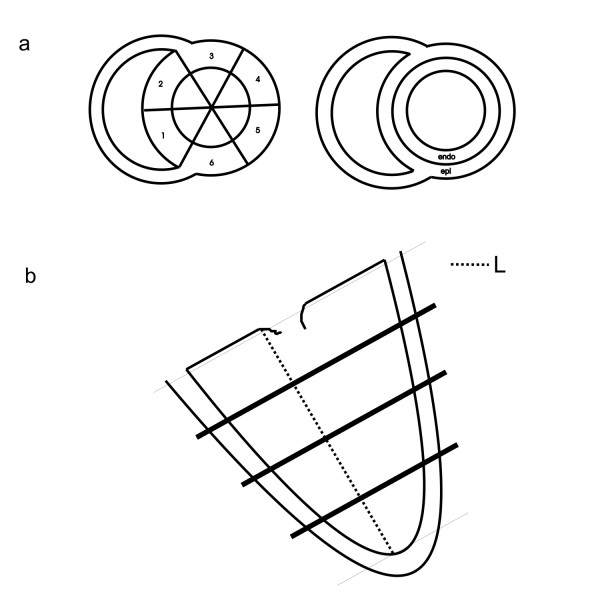
(a) Arrangement of the LV myocardial wall into circumferential segments (left), or transmural layers (right). (b) To localize the basal, mid and apical planes, the length (L) between the apex and the mitral valve in end systole is divided into four equal parts. The planes that are used for short-axis tagging are then located at a distance of 1/4, 1/2 and 3/4 of L from the mitral valve plane.